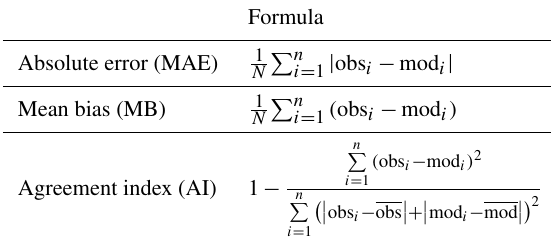
Table A2. IWV validation metrics used in Table 1 and Fig. 10 in Sect.